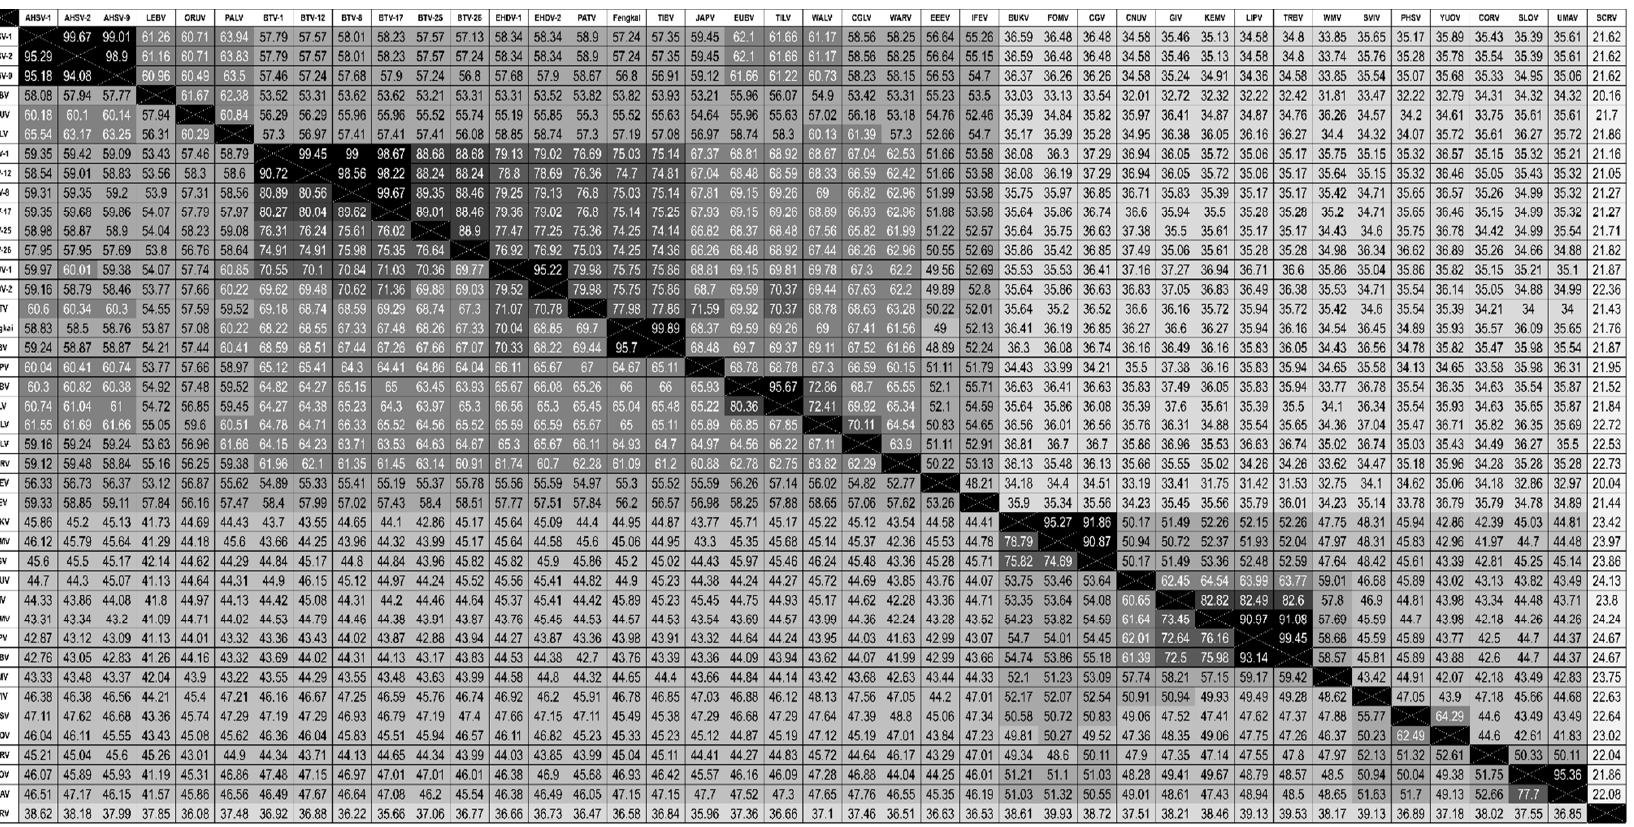
Figure 5. Matrix of T2 pairwise identity percentages of nucleotide (lower left) and amino acid (upper right) between members of the genus Orbivirus .